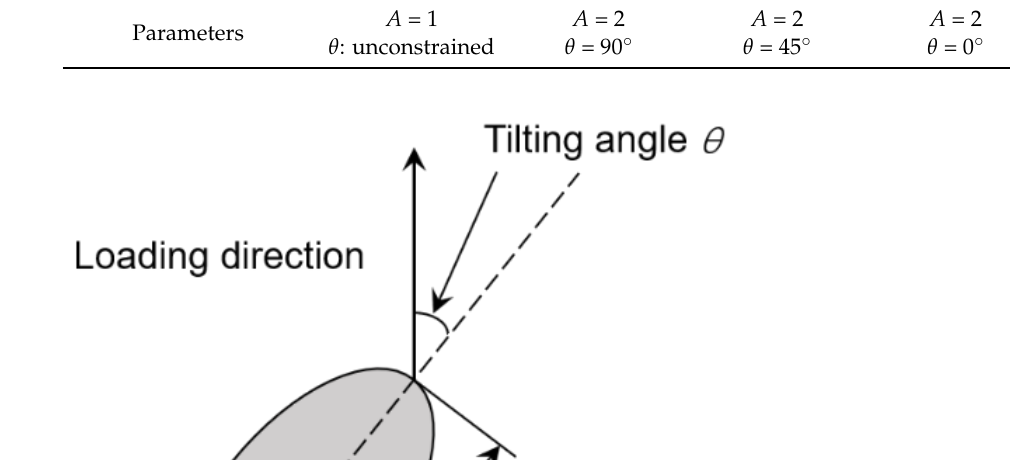
Figure 2. Schematic drawing of the aspect ratio, A , and the tilting angle, θ , of an inclusion.